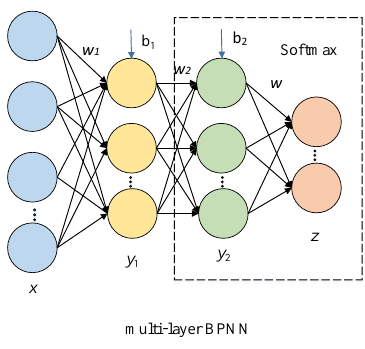
Figure 3. SSAE based multi-layer back propagation neural network (BPNN).